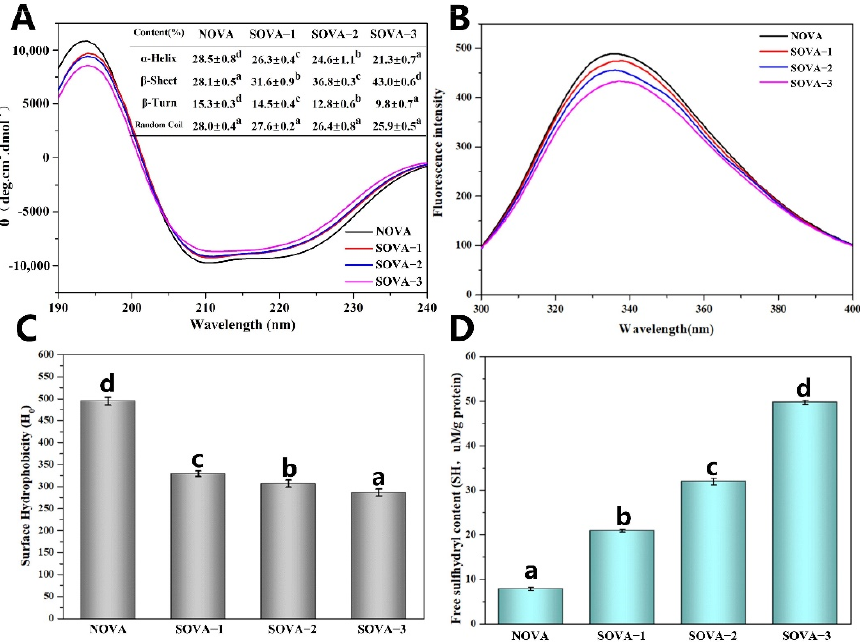
Figure 1. Nucleophilic substitution mechanism of OVA and succinic anhydride ( A ), succinylation degree ( B ), FTIR spectroscopy( C ), SDS − PAGE patterns ( D ), and DSC thermograms ( E ) of OVA with a different succinylated degree. Different letters indicate significant differences ( p < 0.05).